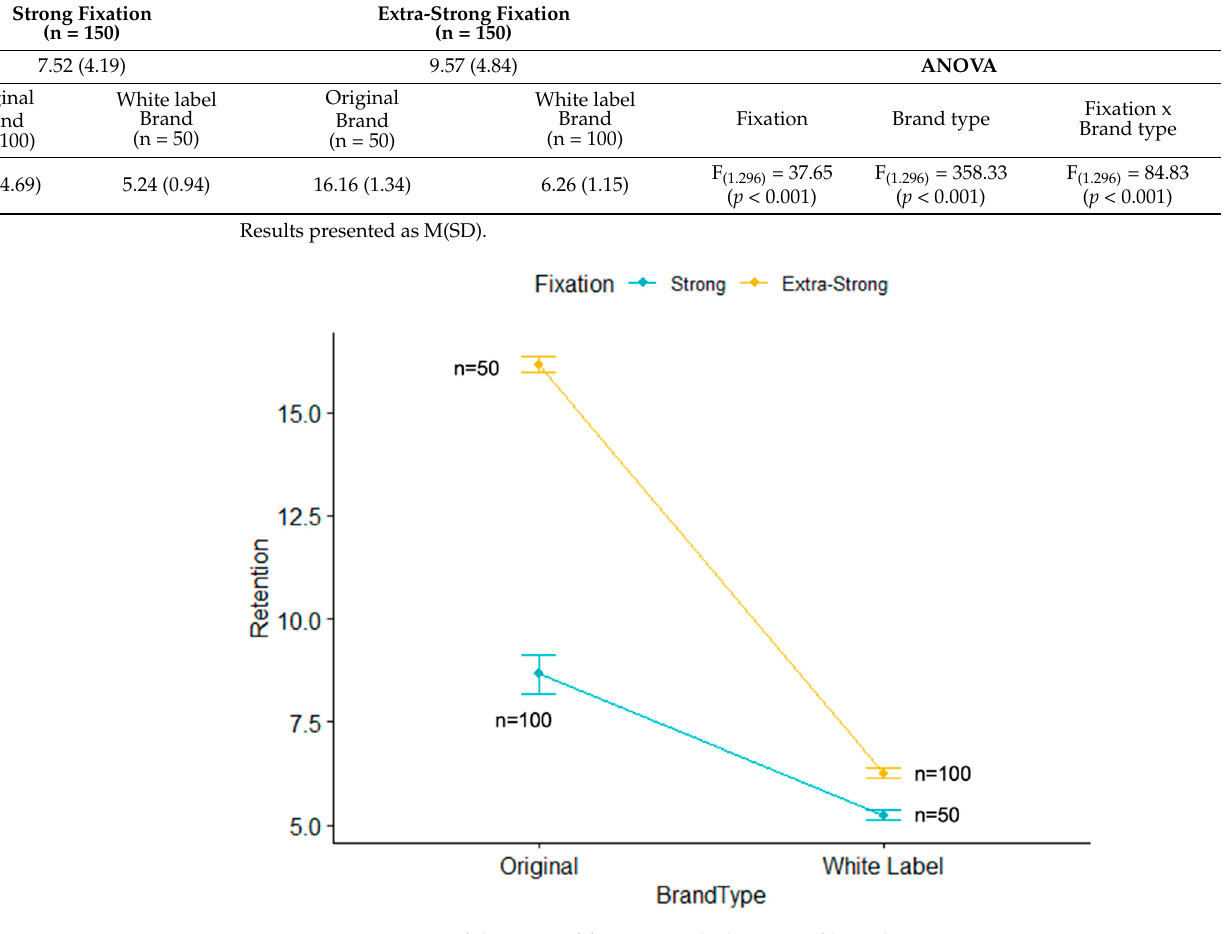
Table 4. Comparisons of the adhesive retention by fixation and brand type.